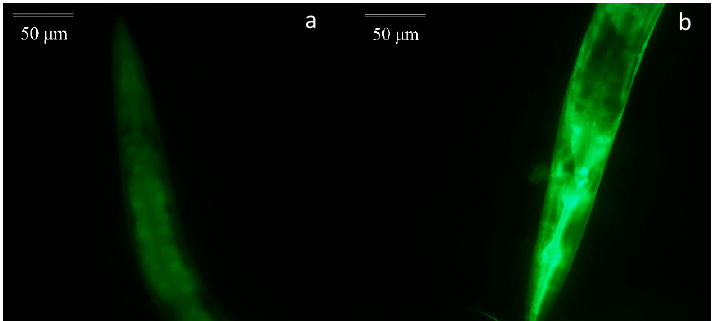
Figure 6. The effect of EOL on expression of HSP-16.2 in C. elegans . Differences were considered significant at p < 0.001 (***).